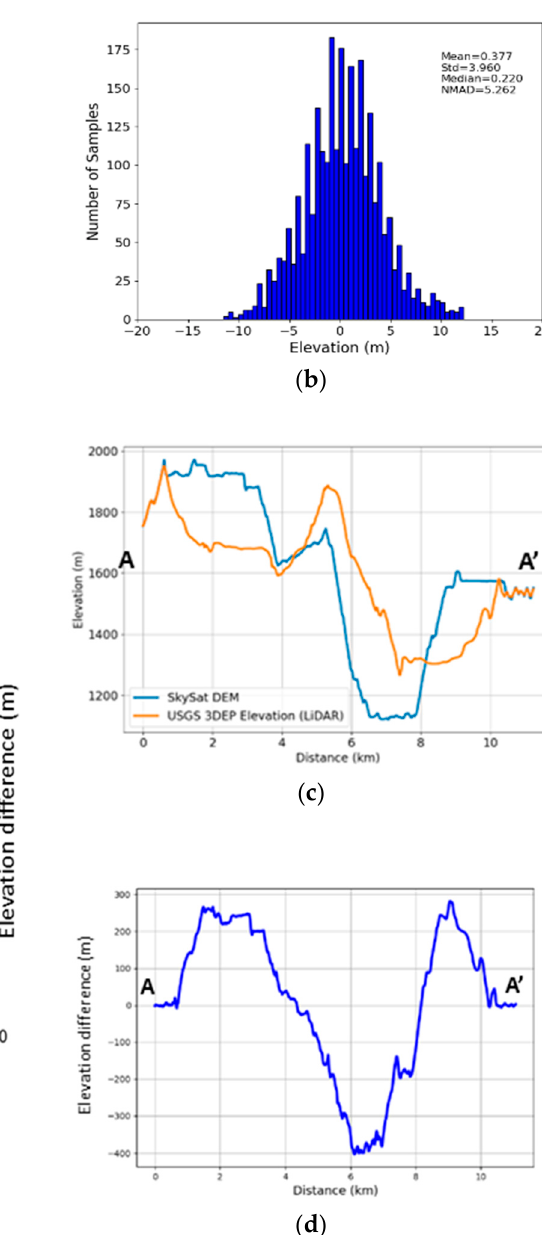
Figure 10. ( a ) Elevation changes over the Morenci Mine area computed from the difference of 2016 3DEP LiDAR and January 2019 SkySat DEM; ( b ) Histogram of the elevation difference over stable terrain (panel ( a ) blue box); ( c ) Elevation profiles from SkySat and LiDAR DEMs; ( d ) Elevation difference profile. Profiles are extracted along transect AA’ indicated in panel ( a ).